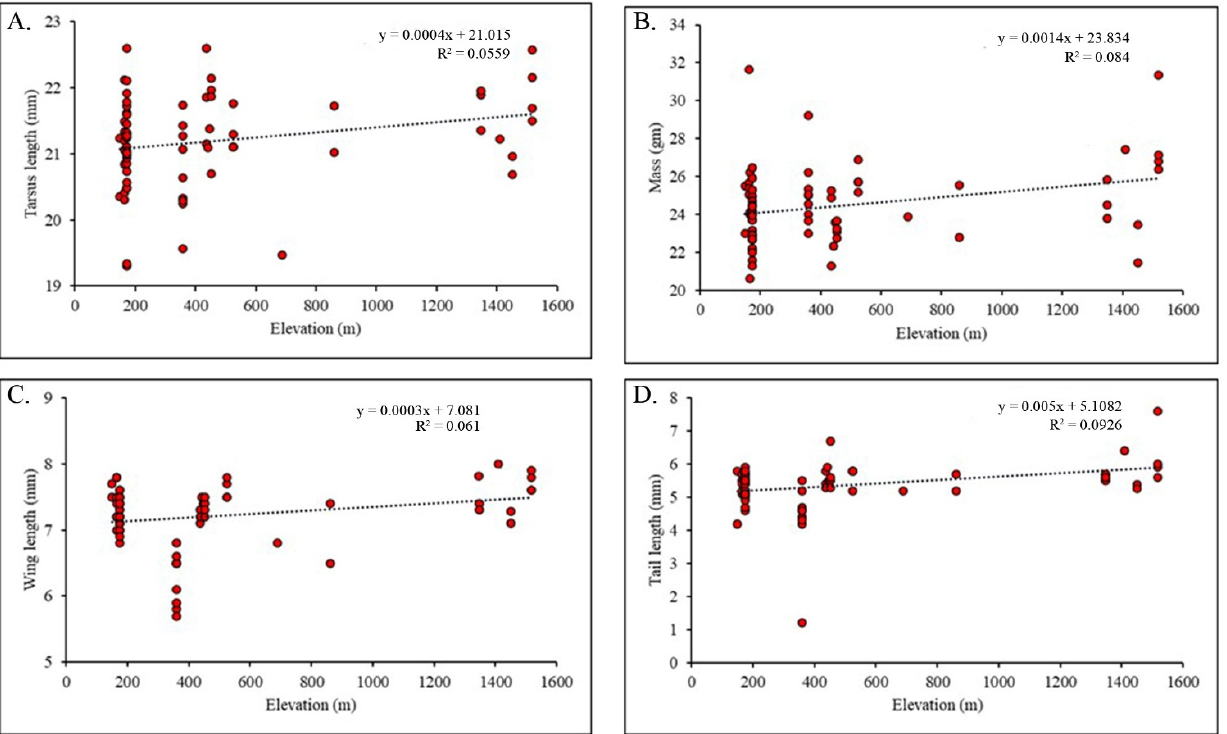
Figure 4. Morphological variations as a function of elevation in Passer domesticus . ( A ). Tarsus length vs. elevation; ( B ). Body mass vs. elevation; ( C ). Wing length vs. elevation; and ( D ). Tail length vs. elevation.